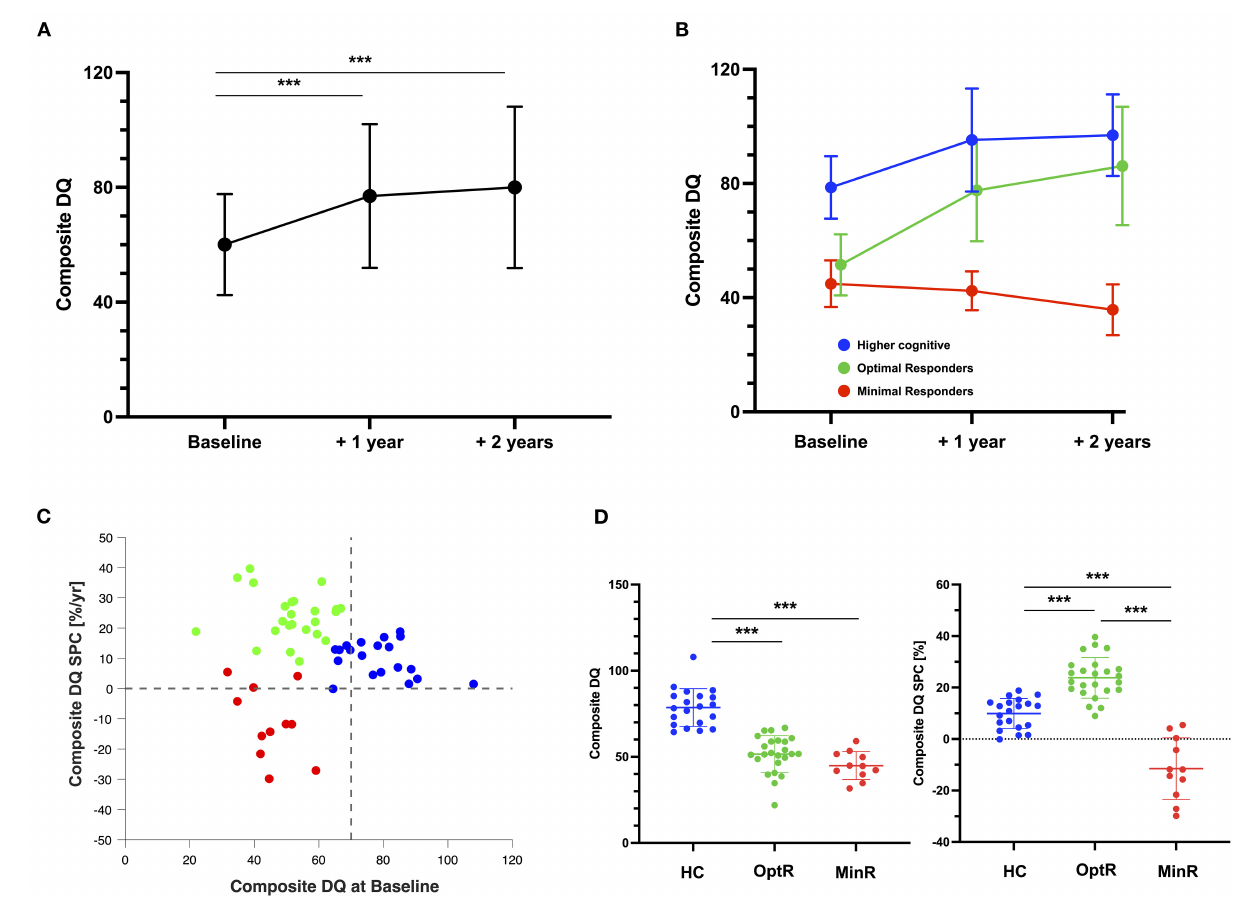
FIGURE 1 | (A) Composite DQ trajectory of the total sample over the 2 years of intervention. Significant results of repeated measure ANOVA are displayed. (B) Composite DQ trajectories of the three subgroups parsed by the cluster analysis. (C) Individual values of the two measures used in the clustering analysis algorithm (composite DQ at baseline and DQ SPC over the 2 years of interventions). Color code represents the cluster membership of each participant after the application of the cluster analysis. (D) Differences between the three subgroups on the two measures that were used to parse them. *** p < 0.001. DQ, Developmental quotient; HC, Higher cognitive; MinR, Minimal responders; OptR, Optimal responders; SPC, Symmetrized percent change.